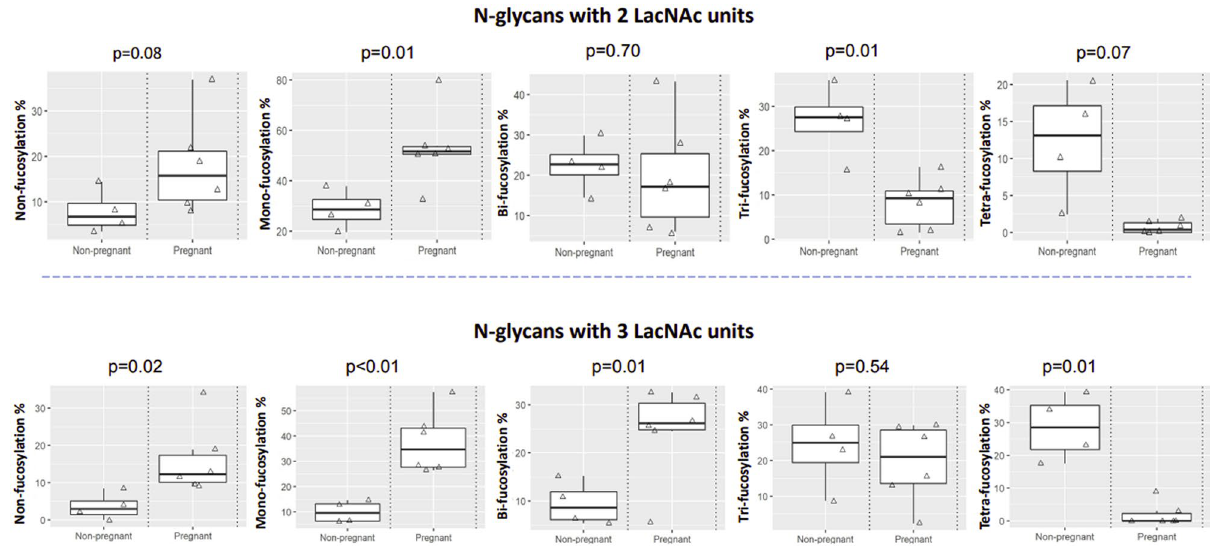
Figure 4. Fucosylation variations between non-pregnant and pregnant samples. N-glycans with 2 LacNAc units (top panel) and 3 LacNAc units (bottom panel) were selected for analysis. The proportion of summed intensity of glycans with non-fucosylation, mono-fucosylation, bi-fucosylation, tri-fucosylation and tetra-fucosylation to total glycan intensity was calculated for data